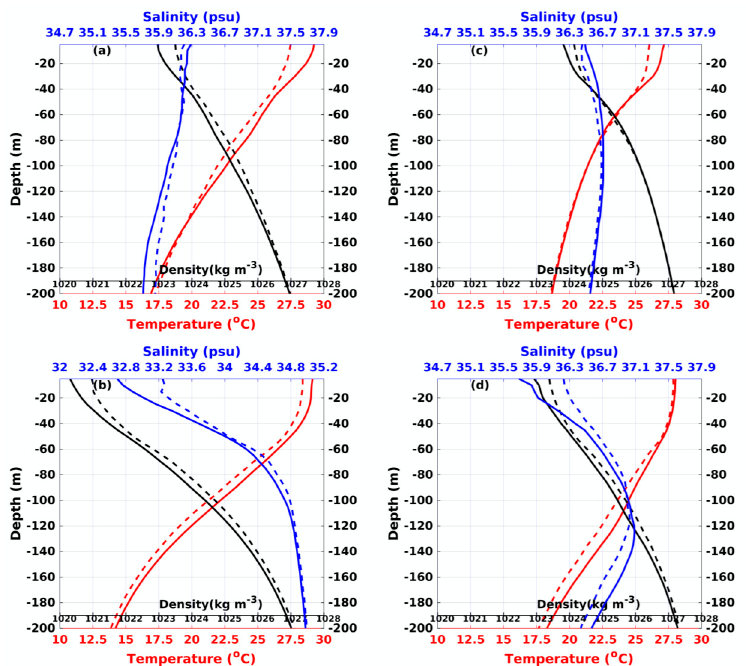
Figure 14. Composite temperature, salinity and density profiles during the reference time period (solid line) and averaged 1–5 days after the passage of the TCs (dashed line) for all storms averaged within the centered 2° × 2° box during 2002 to 2019 in the ( a ) AS, ( b ) BoB, ( c ) SNA and ( d ) AOP, with in-situ data from Argo floats.